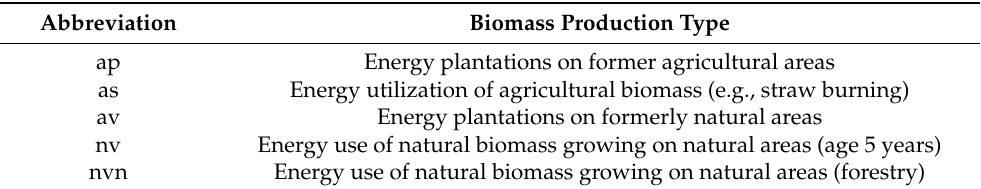
Table 1. The five biomass production types in the CEBM. The abbreviation combines the former allocation of the given area (natural or agricultural: first letter) and the form of growth (second letter). Abbreviation Biomass Production Type ap Energy plantations on former agricultural areas as Energy utilization of agricultural biomass (e.g., straw burning) av nv